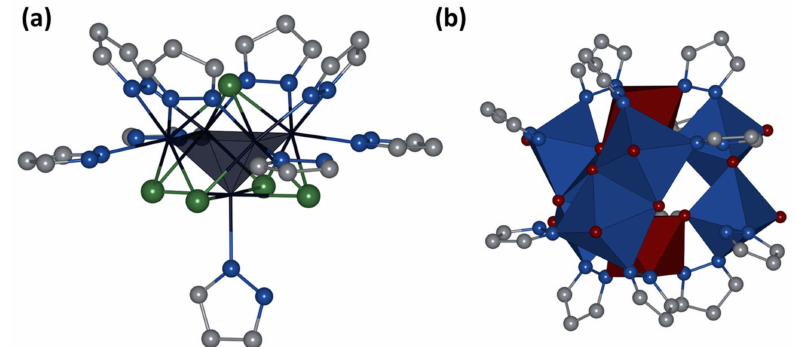
Figure 2. Crystal structure of cluster cation [{Mo 5 ( µ 3 -Se) 4 ( µ 4 -Se)( µ -pz) 4 }(pzH) 5 ] + in Mo 5 red ( a ) and hybrid POM from [31] ( b ). Hydrogen atoms are omitted for clarity. Color code: Mo—dark blue, Mo 5 —dark blue square pyramid, Se—green, C—gray, N—blue, Mo V 2 O 6 N 4 —blue edge-connected octahedrons, Mo VI O 3 N 3 —dark red